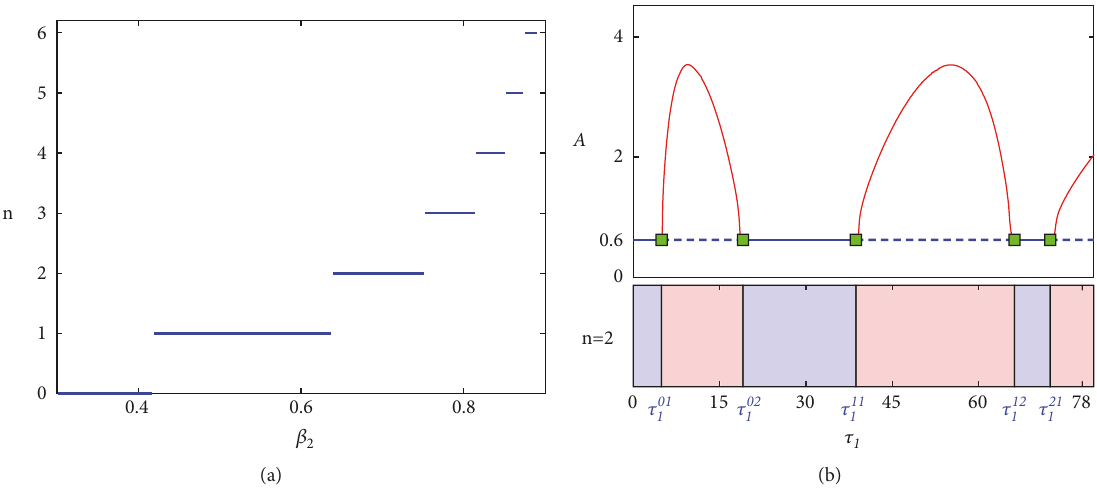
Figure 5: (a) The number of intervals for stability switches of positive equilibrium with respect to 𝛽 2 , where 𝜏 2 = 0 ; (b) based on (a), an example for comparison between results predicted by linear analysis and numerical results in the fully nonlinear regime with ( 𝛽 2 ,𝜏 2 ) at (0,0.7) , where top panel represents numerical results for model (1) in the fully nonlinear regime; bottom panel depicts the results predicted by linear analysis, and blue and red area denote stable and unstable,